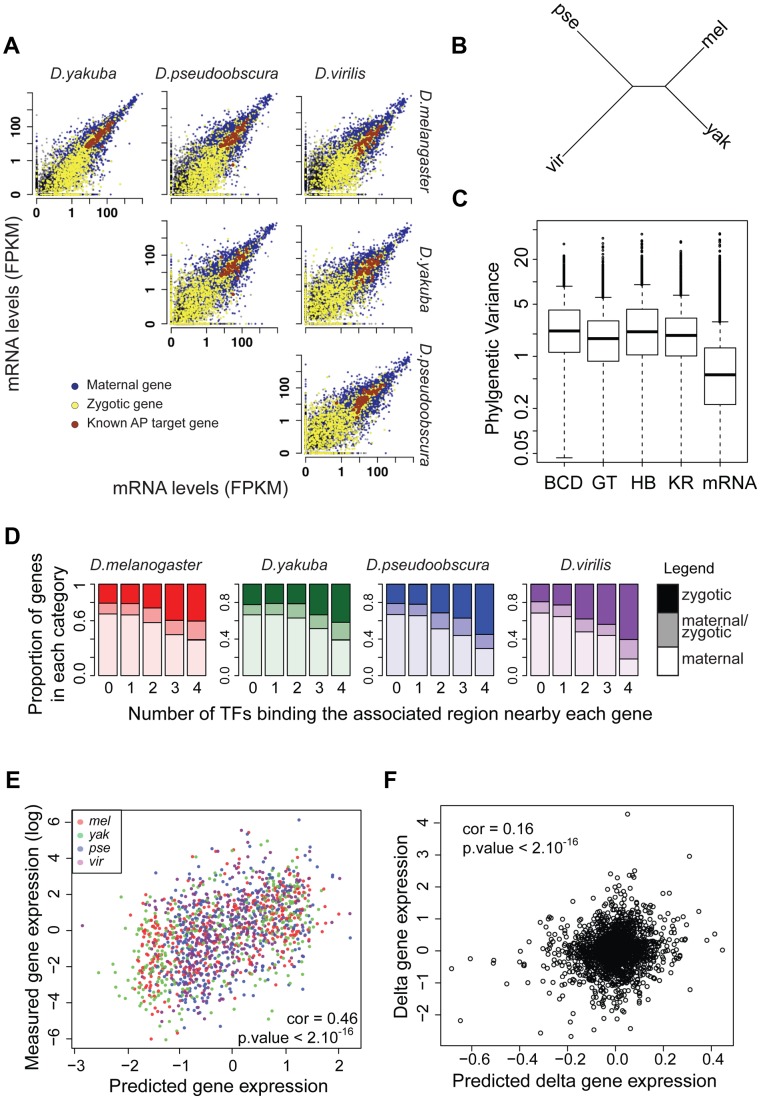
mRNA levels are highly conserved despite high divergence of BCD, GT, HB and KR binding.
A. Pairwise comparison of mRNA levels in D.melanogaster, D.yakuba, D.pseudoobscura and D.virilis blastoderm embryos. B. Neighbor-joining tree based on pair-wise distance matrices of mRNA levels, based on Spearman's correlation coefficient. C. Phylogenetic variance of mRNA levels is significantly lower than variance of BCD, GT, HB of KR binding (Wilcoxon test p-value<10−16). In order to compare variance, quantitative values were normalized by dividing each dataset by its standard deviation, on which parameters of the Brownian motion model were reestimated. D. Proportion of bound regions associated with maternal, zygotic or maternal-zygotic genes, depending on the number of TFs binding the region. Regions bound by many TFs tend to be localized near zygotic genes whereas isolated peaks tend to be localized near maternal genes. E. mRNA levels of zygotic genes are well predicted by associated TF binding in all species. mRNA levels were predicted from a multiple linear regression of associated nearby TF binding. F. Changes along each branch of the tree of mRNA levels for zygotic genes are modestly but significantly correlated with predicted changes based on quantitative changes of associated TF binding.